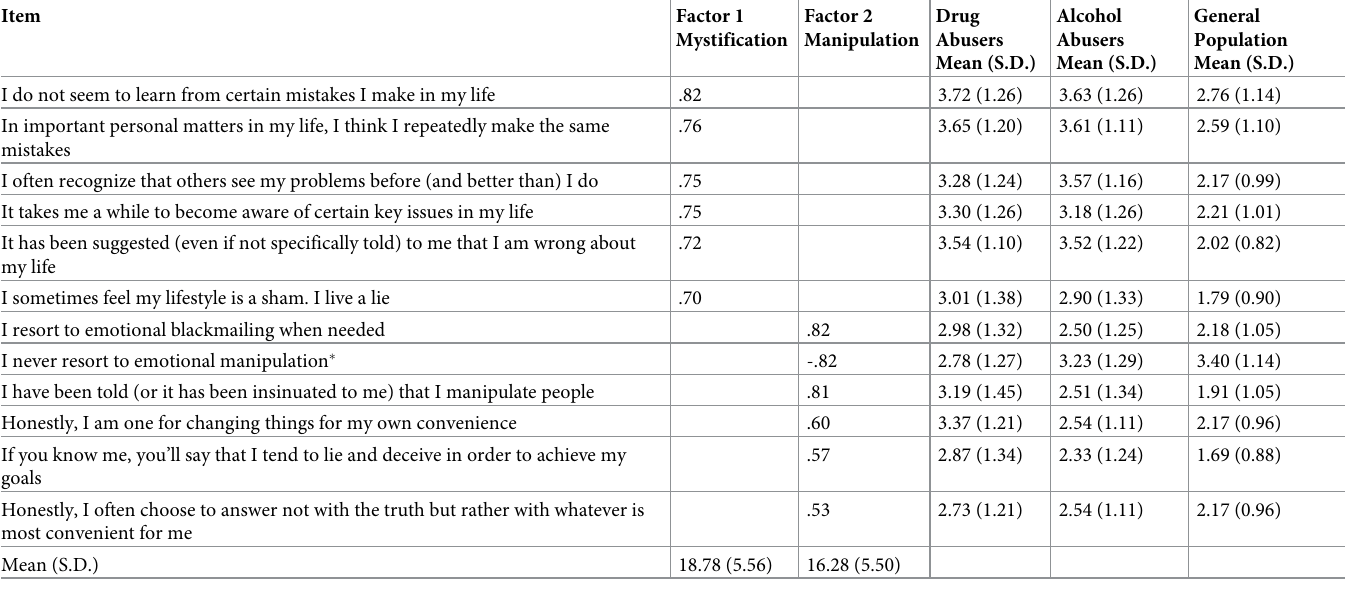
Table 2. Items, factor loadings, means and standard deviations of mystification and manipulation scales (N = 541) 1